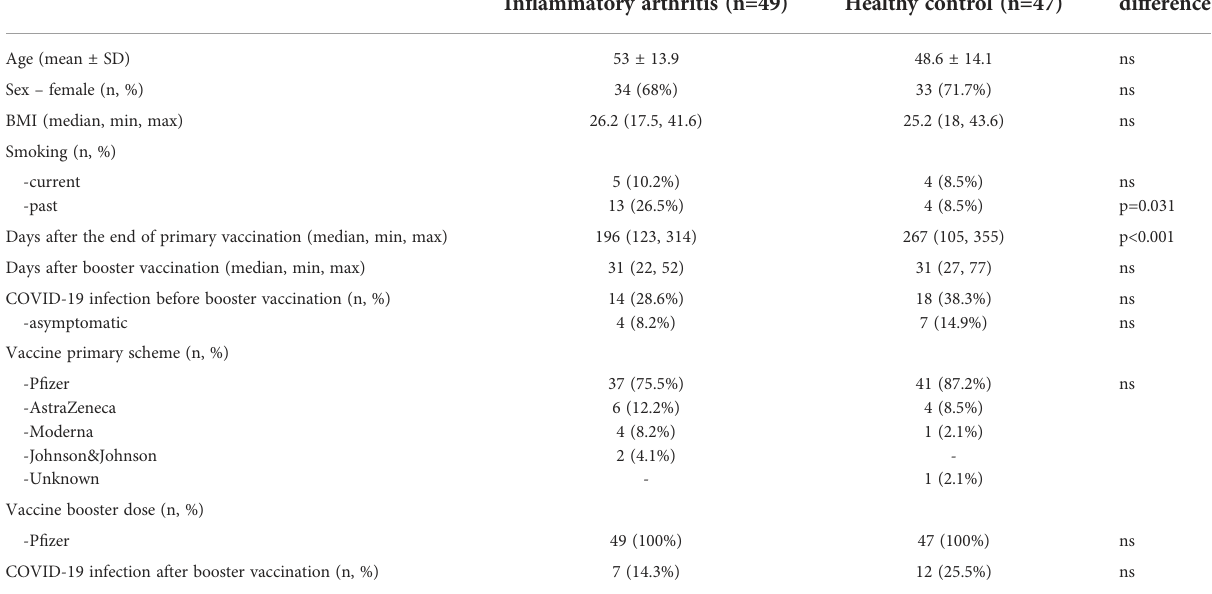
TABLE 1 Patient